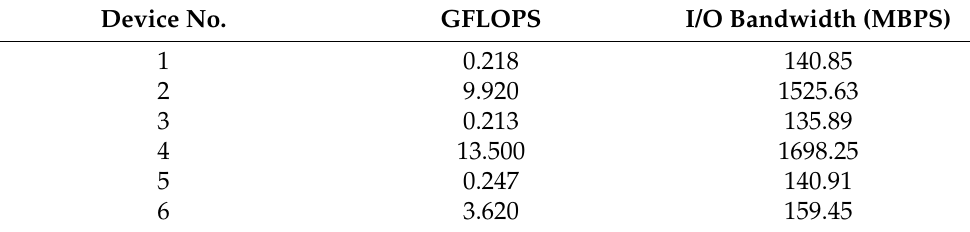
Table 1. Performance parameters of edge devices in experiments on B-AlexNet. Device